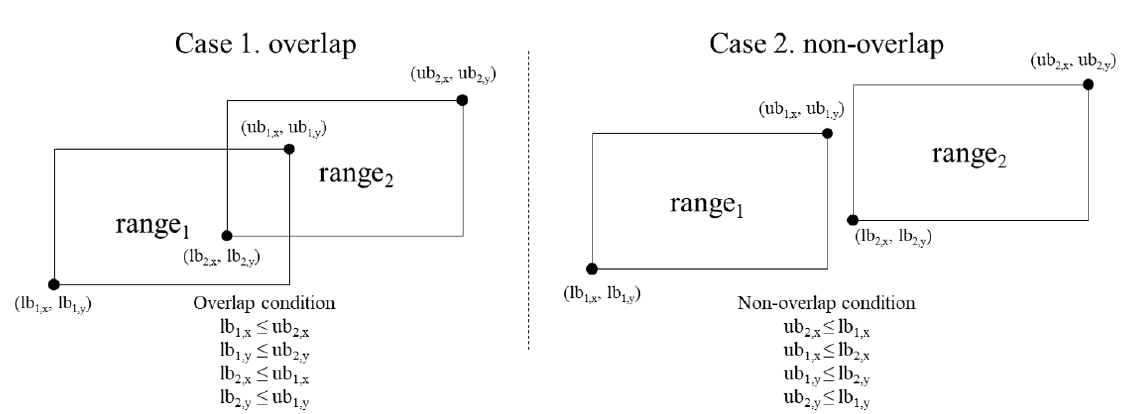
Figure 3. Overlapping and non-overlapping between two regions in the ASRO